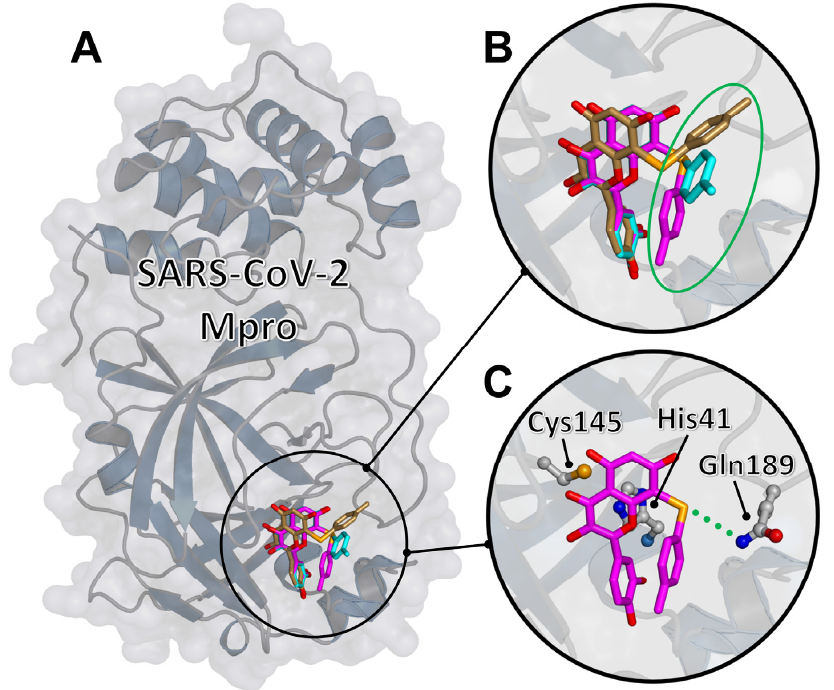
Figure 6. Molecular docking of compound 2d to SARS-CoV-2 M pro . ( A ) The best three docking poses bound in the protein active site. ( B ) Detail of the docking poses highlighting the quercetin scaffold approximately superimposed, while the chemical adduct (circled in green) shows a large variability. ( C ) The most favorable docking pose (binding energy –8.2 kcal/mol), with the side chains of selected protein residues (the catalytic dyad His41/Cys145 and the hydrogen bonded residue Gln189) explicitly shown.